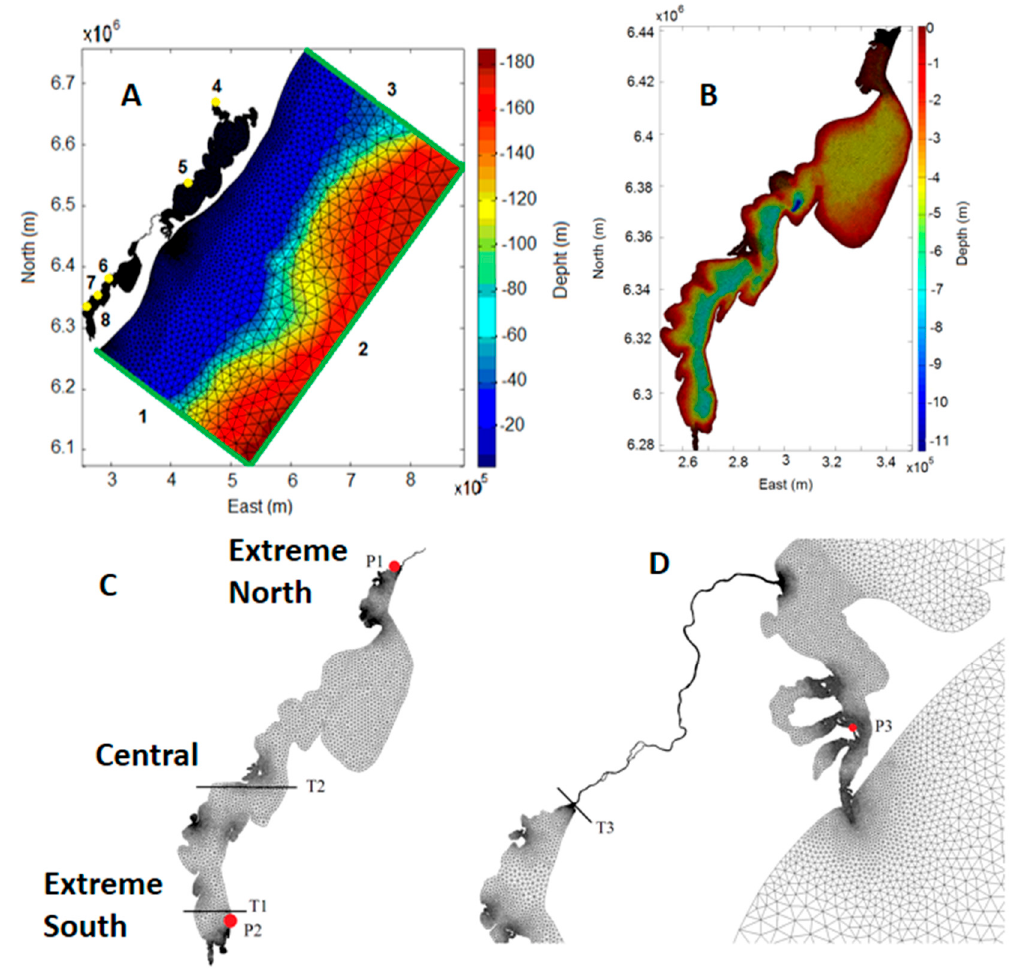
Figure 2. ( A ) Numerical mesh for the hydrodynamic simulations, and its liquid (1, 2, and 3) and continental (4, 5, 6, 7, and 8) boundaries. Current velocity data were prescribed in boundaries 1 and 3; tides and low-frequency sea surface heights in boundary 2; salinity and temperature in all boundaries; freshwater discharge in the boundaries 4 to 8 (Guaíba, Camaquã, Jaguarão, Taquari, and Cebollati rivers, respectively). ( B ) Detail of the Mirim lagoon region; ( C ) Location of stations P1 (Santa Izabel) and P2 (Santa Vitória do Palmar); location of transects T1 and T2. ( D ) Detail for the São Gonçalo channel region, which connects the two lagoons; location of station P3 and transect T3.